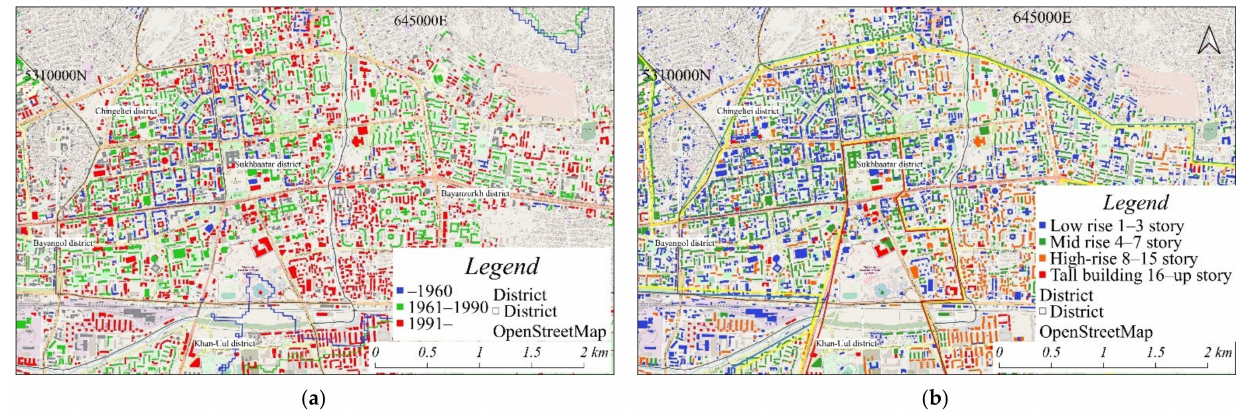
Figure 3. ( a ) Close-up map of construction year distribution in Ulaanbaatar; ( b ) close-up map of the distribution of building heights.